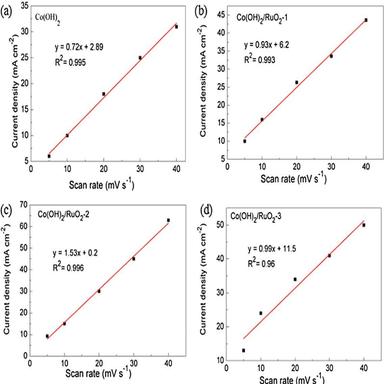
(a) The capacitive currents of Co(OH)2 at 0.4 V with various scan rate of 5, 10, 20, 30 and 40 mV s−1 ; the capacitive currents of (b) Co(OH)2/RuO2-1, (c) Co (OH)2/RuO2-2 and (d)Co(OH)2/RuO2-3 at 0.5 V with various scan rate of 5, 10, 20, 30 and 50 mV s−1 .